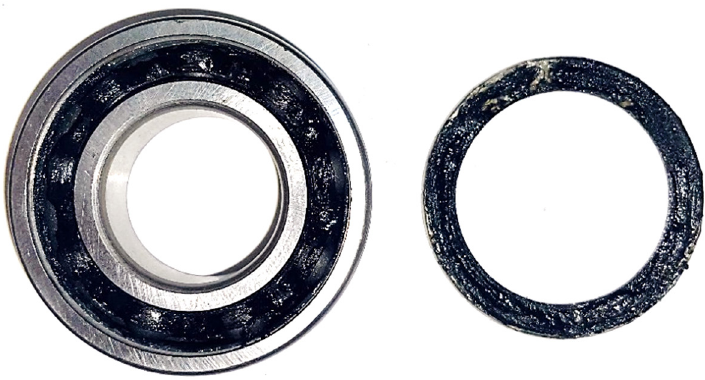
Figure 5. Darkened lubricant.